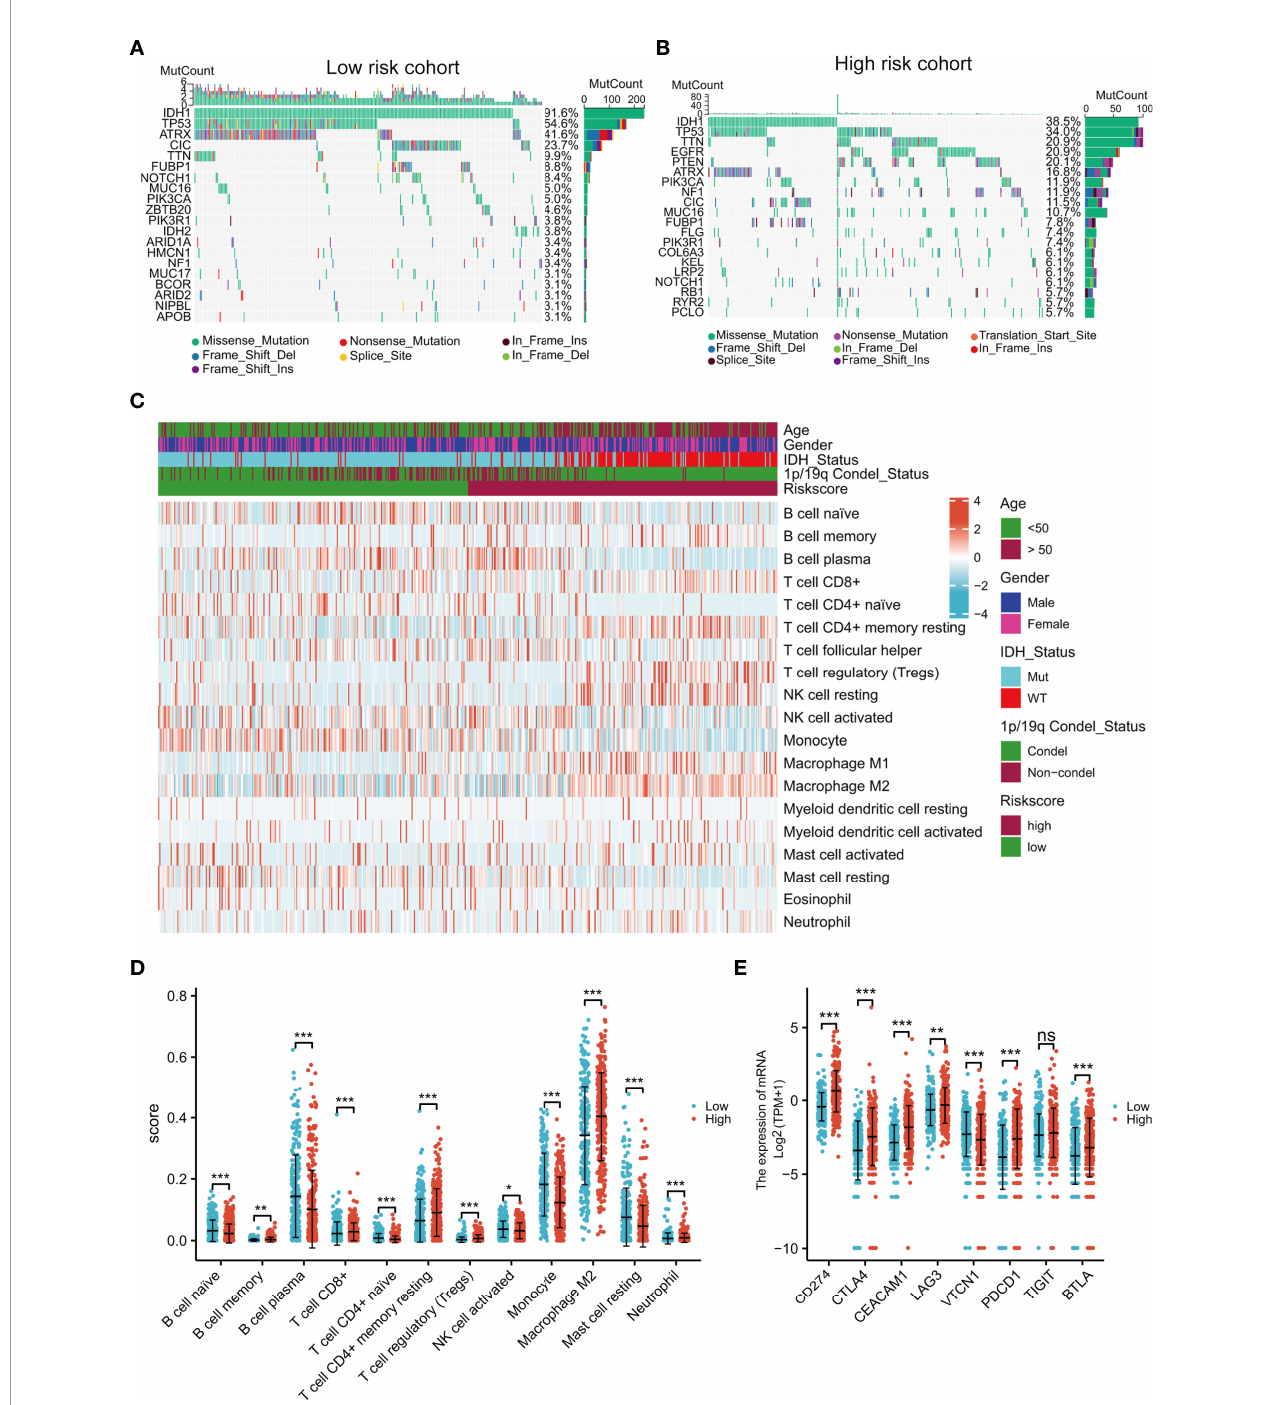
FIGURE 6 | Comprehensive analyses of genomic alterations, immune cell in fi ltration, and immune checkpoint expression between the different risk groups. Distribution of sex, age, IDH status, 1p/19q condel status, and the top 20 most frequently mutated genes are illustrated for each cohort (A, B) . Heatmap showing the CIBERSORT scores of different immune cell distributions in the different subgroups (C) . Dot plot showing immune cell CIBERSORT scores and the expression levels of immune checkpoint gene in the high- and low-risk groups (D, E) . ns, no signi fi cance,*p < 0.05, **p < 0.01, ***p <